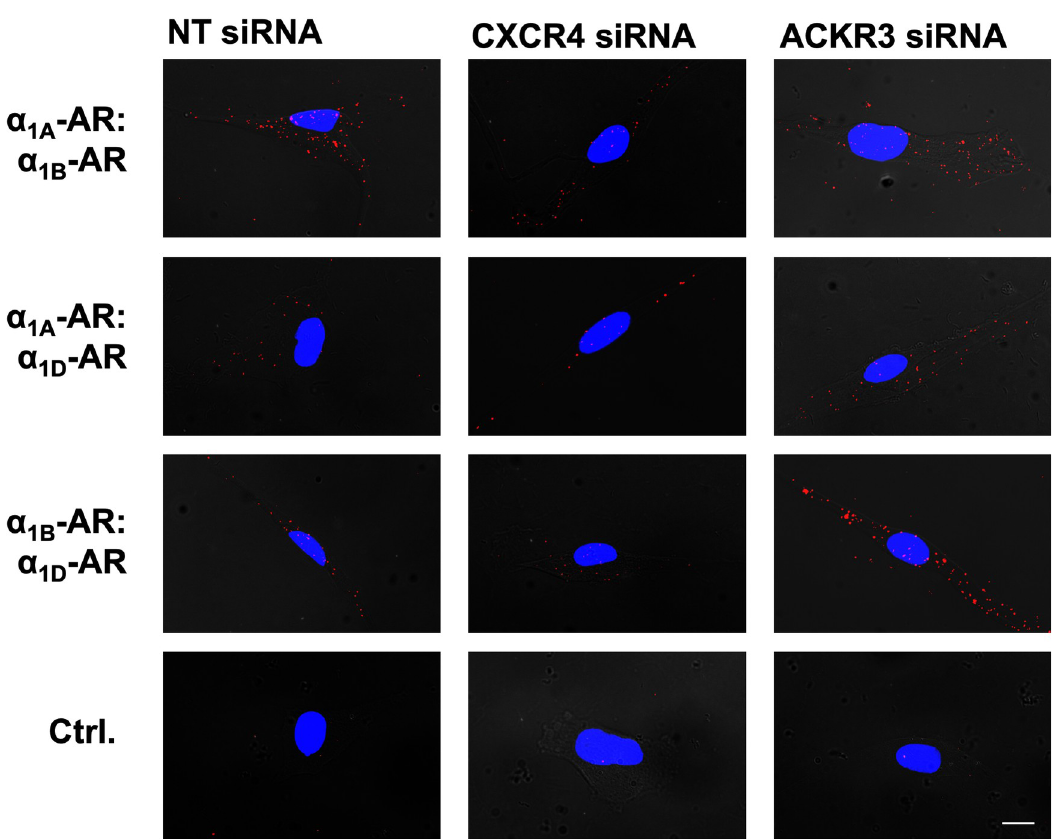
Fig 5. Detection of α 1A/B/D -AR heteromers after depletion of CXCR4 or ACKR3 in hVSMCs. Representative PLA images for the detection of α 1A/B/D -AR heteromers in hVSMCs after incubation with non-targeting (NT) siRNA (left), CXCR4 siRNA (center), or ACKR3 siRNA (right). Ctrl: Omission of one primary antibody. Images show merged PLA/4 0 ,6-diamidino-2-phenylindole dihydrochloride (DAPI) signals. Scale bar = 10 μ